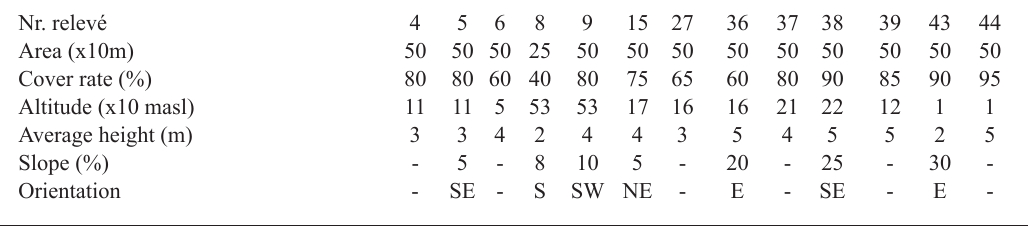
Solano microphylli-Leptochloopsietum virgatae Cano, Veloz & Cano-Ortiz